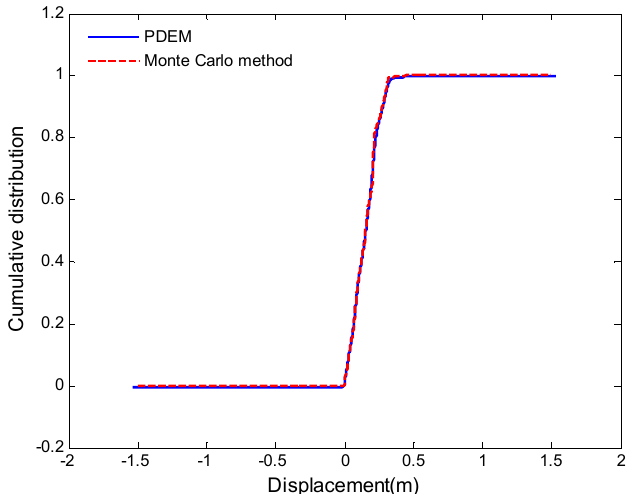
Figure 9. PDFs evolution surface of displacement.